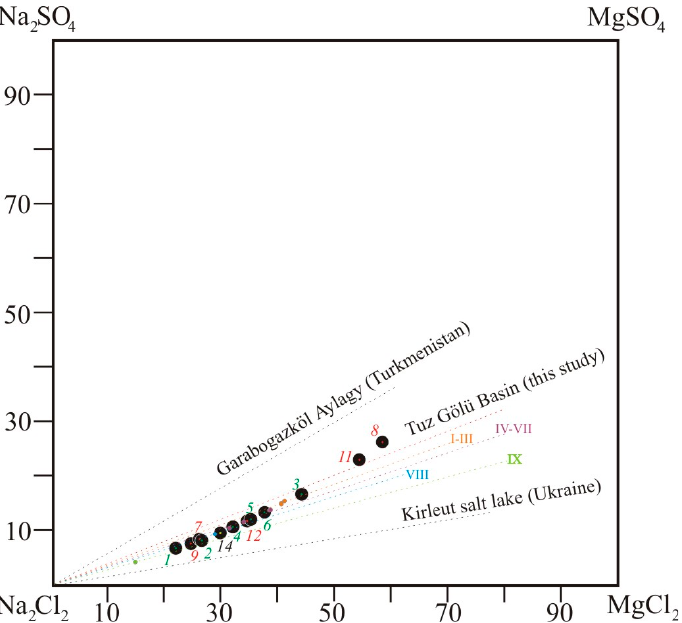
Figure 8. Chemical composition of brines in the Na 2 Cl 2 –MgCl 2 –MgSO 4 –Na 2 SO 4 diagram, point numbers according to Table 2. The straight lines passing through the Na 2 Cl 2 vertex and forming an acute angle with the Na 2 Cl 2 –MgCl 2 line are individual due to the crystallization of halite in each basin